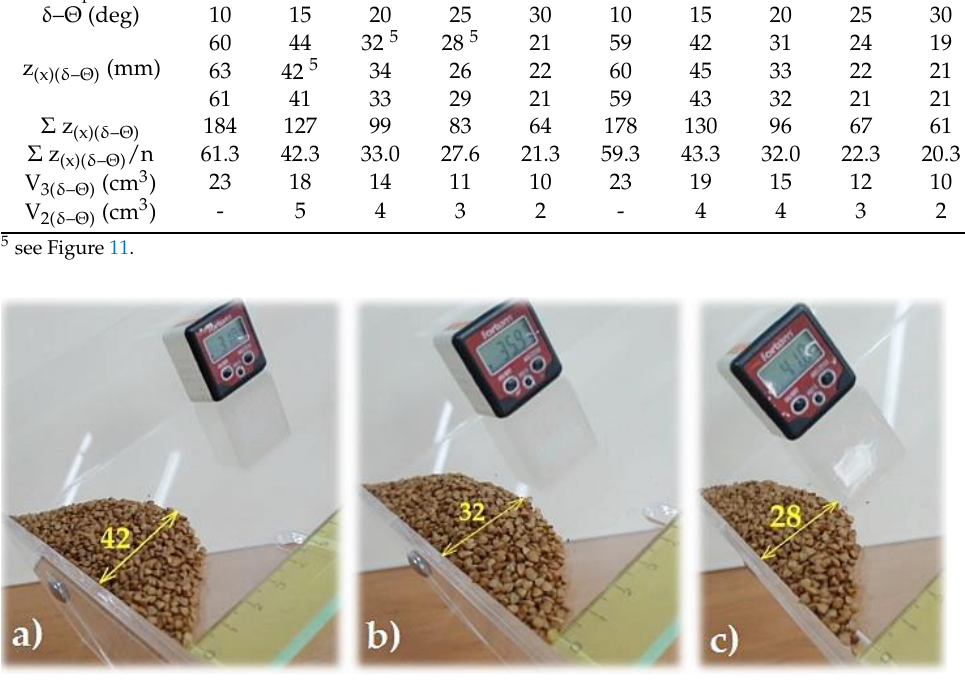
Figure 11. Batch volume V i [cm 3 ] buckwheat spread on the surface of the conveyor belt for H 1 = 10 mm. Length of the distribution z (x) for δ – Θ (deg) ( a ) 15 deg, ( b ) 20 deg and ( c ) 25 deg. Table 6. Volume of material V i( δ – Θ ) [cm 3 ] for H 1 = 15 mm belt cleat